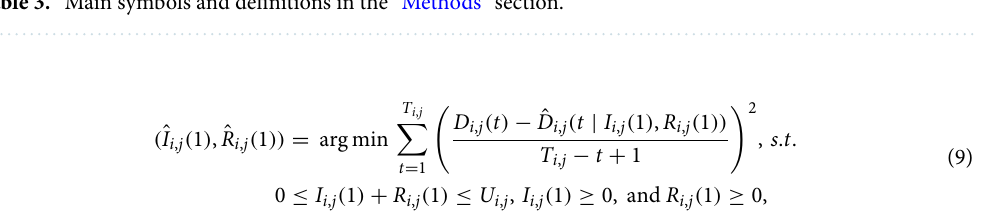
Table 3. Main symbols and definitions in the “Methods”